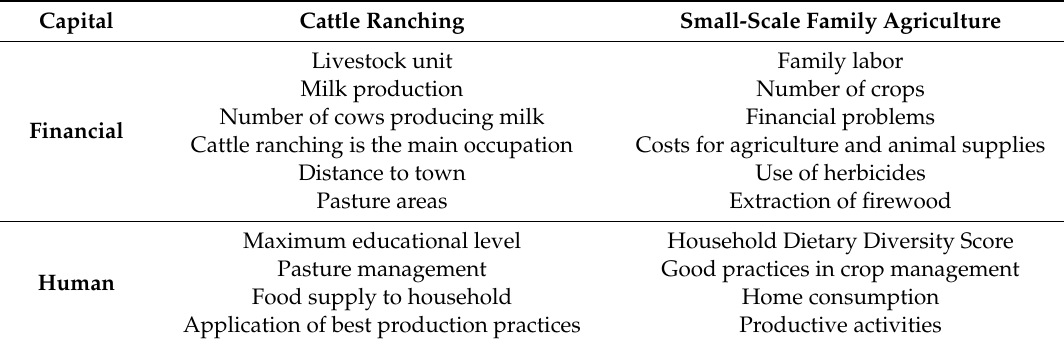
Table 2. Variables used to evaluate the five capitals of the cattle ranching and small-scale family agriculture